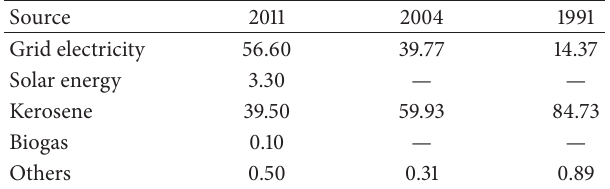
Table 2: Source of lights (in